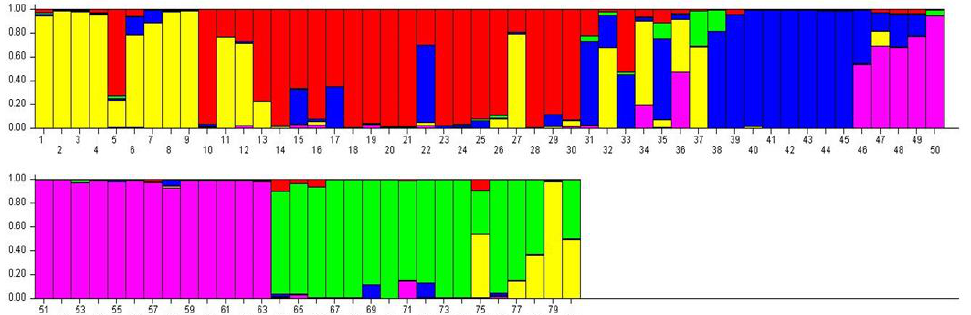
Figure 5. The population structure of 80 genotypes assessed using Bayesian analysis with allelic variation from the 11 iPBS markers. Five populations (yellow, red, blue, purple, and green) were defined using the method described in Evanno et al. (2005). Each vertical line symbolizes an indi- vidual multi-locus genotype.